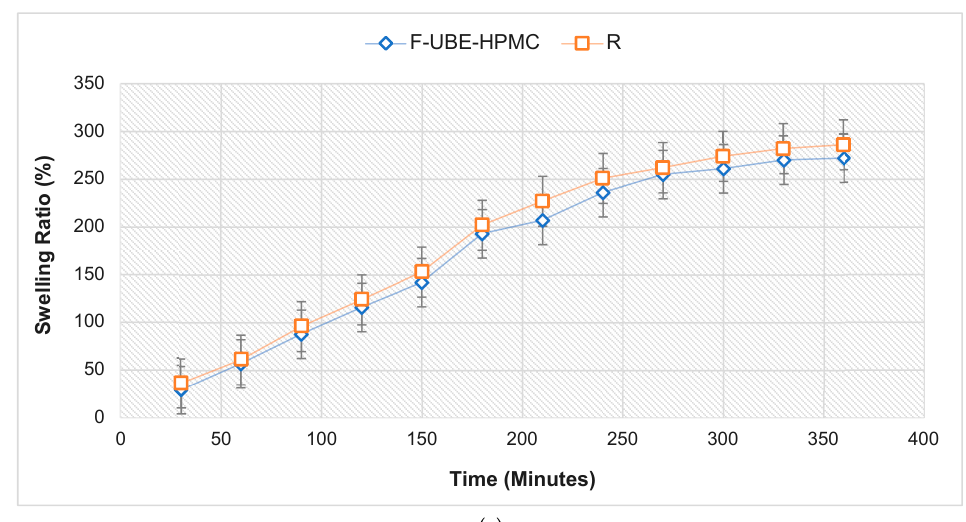
Figure 2. FTIR Spectra of mucoadhesive oral patches ( a , b ): Reference (red line) and F-UBE-HPMC (black line) in the range 4000–2200 cm − 1 ( a ) and 2000–400 cm − 1 ( b ); X-ray Diffractograms of Reference and F-UBE-HPMC oral mucoadhesive patches ( c ); Thermogravimetric analysis coupled with differ- ential thermal analysis of the mucoadhesive oral patches ( d ). Swelling rate% over 6 h of F-UBE- HPMC versus R ( e ). R—Reference (patch without UBE); F-UBE-HPMC—mucoadhesive oral patches loaded with UBE; UBE— U. barbata dry ethanol extract.